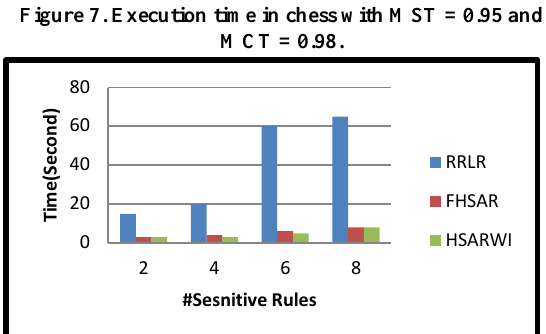
Figure 3. Lost rules in Mushroom with MST = 0.5 and MCT = 0.75.